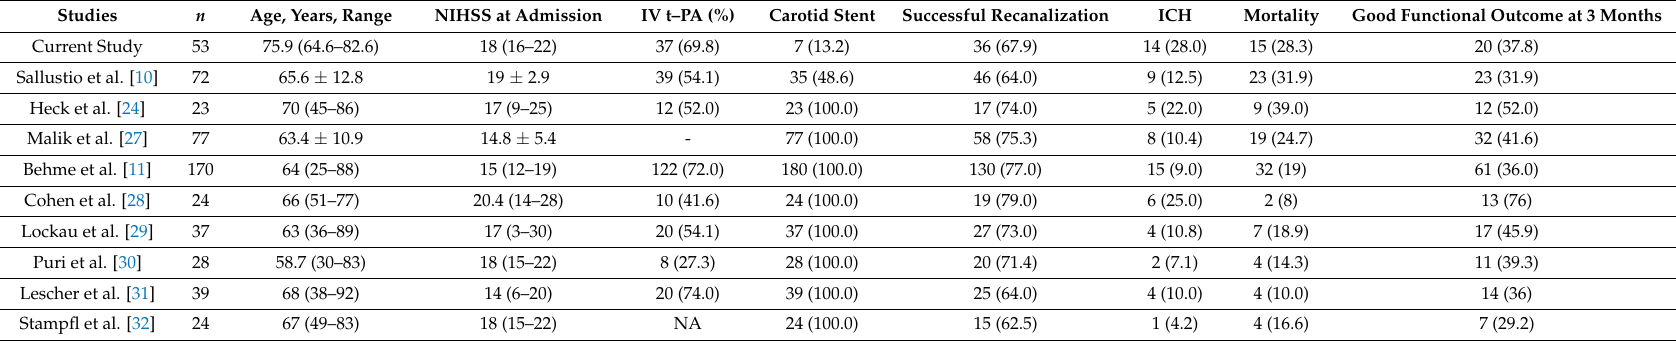
Table 4. Review of previous studies on endovascular treatment of tandem occlusion of internal carotid/middle cerebral